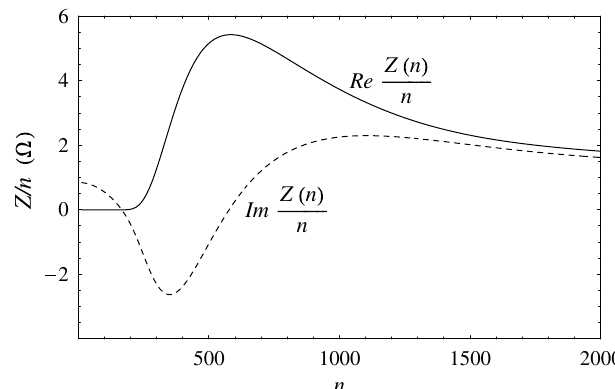
FIG. 1. Real (solid line) and imaginary (dashed line) part of Z (cid:3) n (cid:4) =n for the parallel plate model with h (cid:2) 1 cm , R (cid:2) 25 cm , (cid:2) 25 MeV and energy E 0